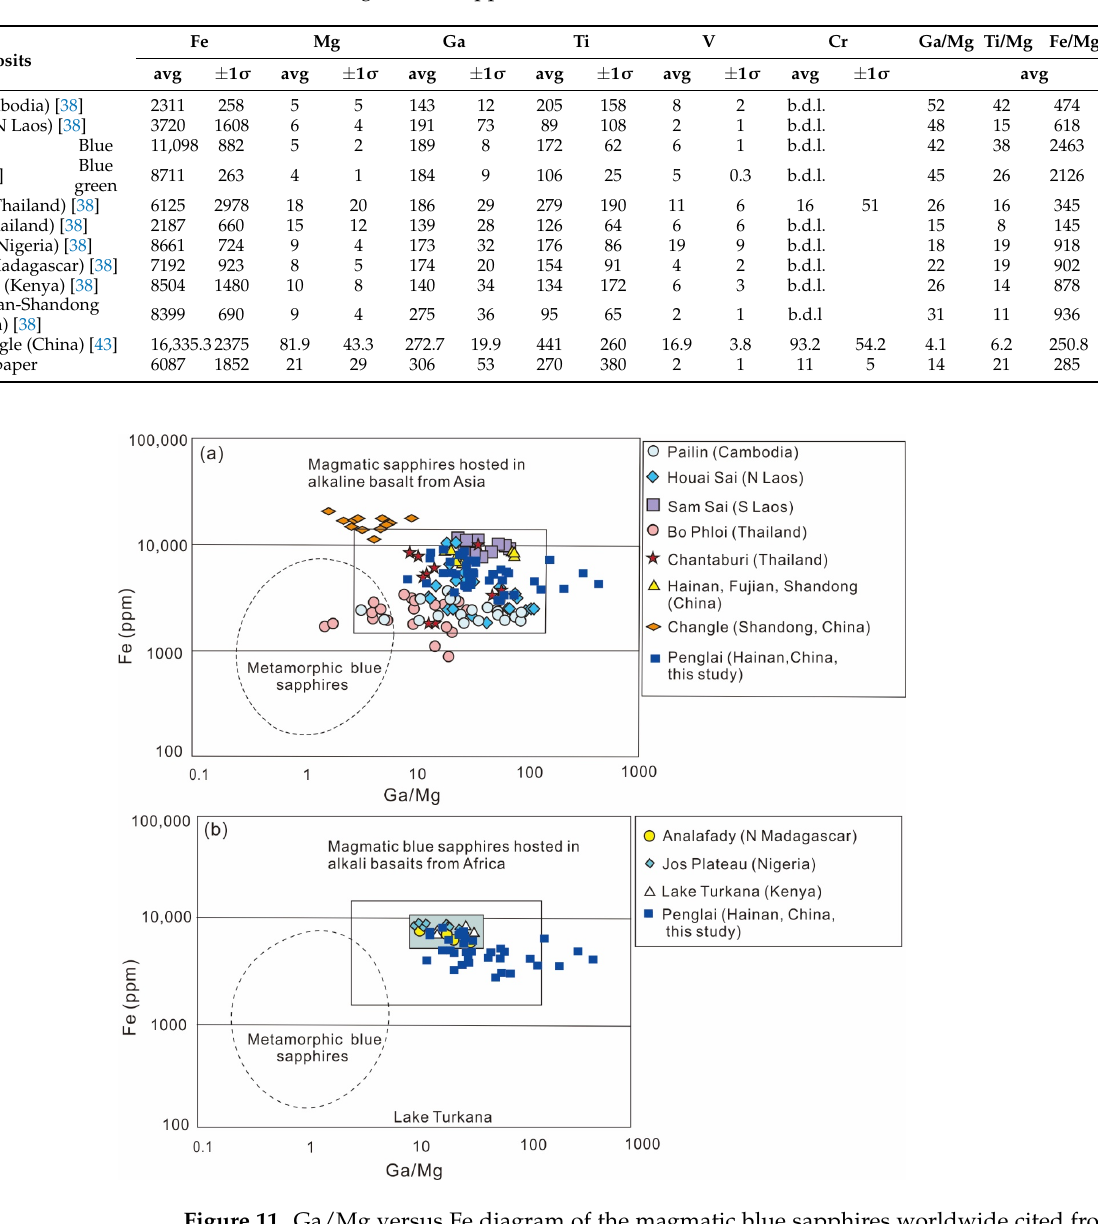
Table 3. Trace element contents of the Penglai sapphire in Hainan, China, and other basaltic sapphires worldwide (average value in ppm); b.d.l. = below detection limit.